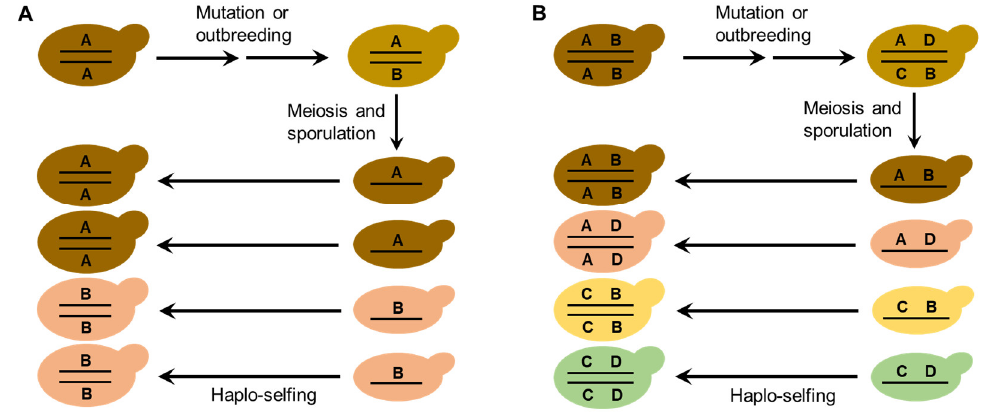
Figure 6. A schematic illustration of a modified Mortimer’s genome renewal model for explaining the diversification of wild S. cerevisiae strains. Theoretically, in the case of one neutral mutation in one locus ( A ), one new homozygous diploid cell line with a new genotype can be created; while in the case of two loci harboring one neutral mutation each ( B ), three new homozygous diploid cell lines with different genotypes can be created via meiotic recombination and haplo-selfing processes.